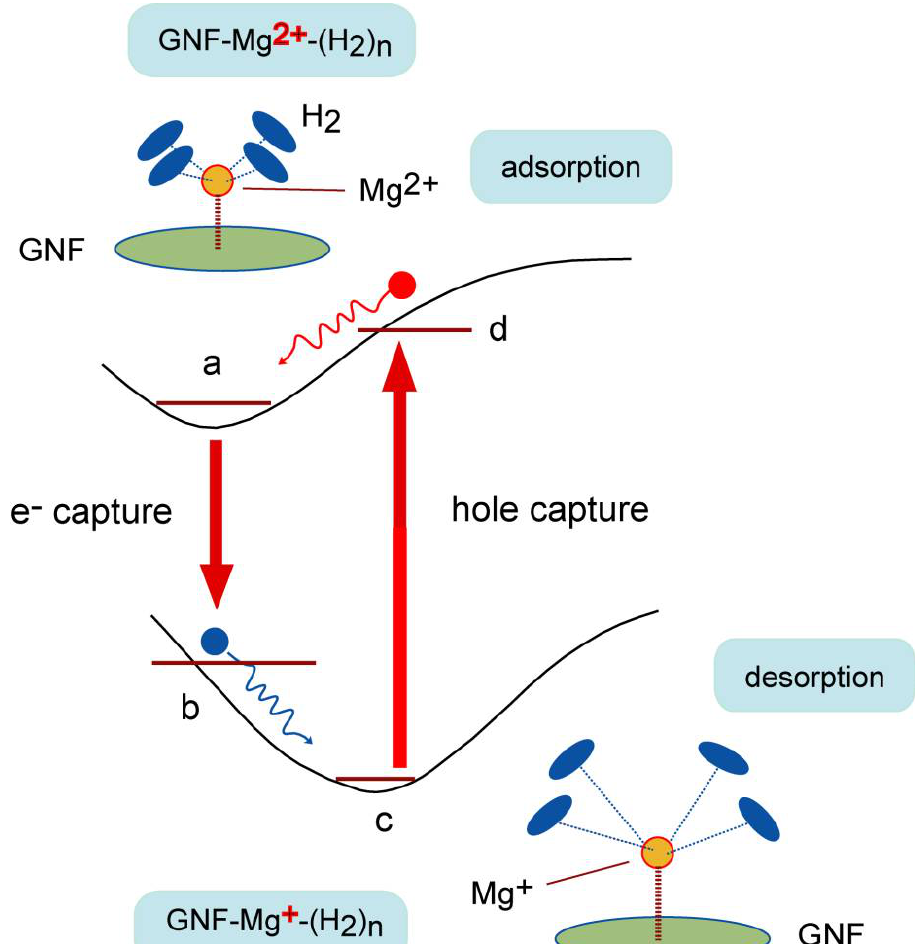
Figure 14. The conceptual diagram for a H 2 adsorption–desorption reversible molecular device.